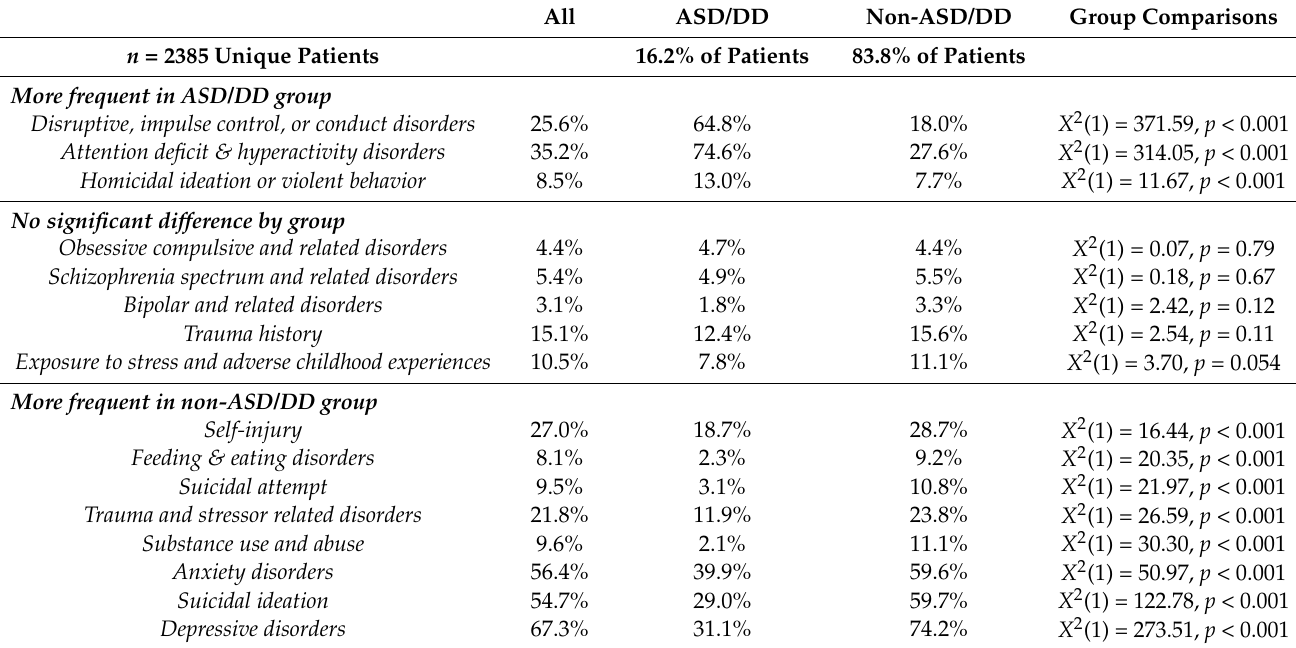
Table 2. Psychiatric features documented among PBMU patients with and without